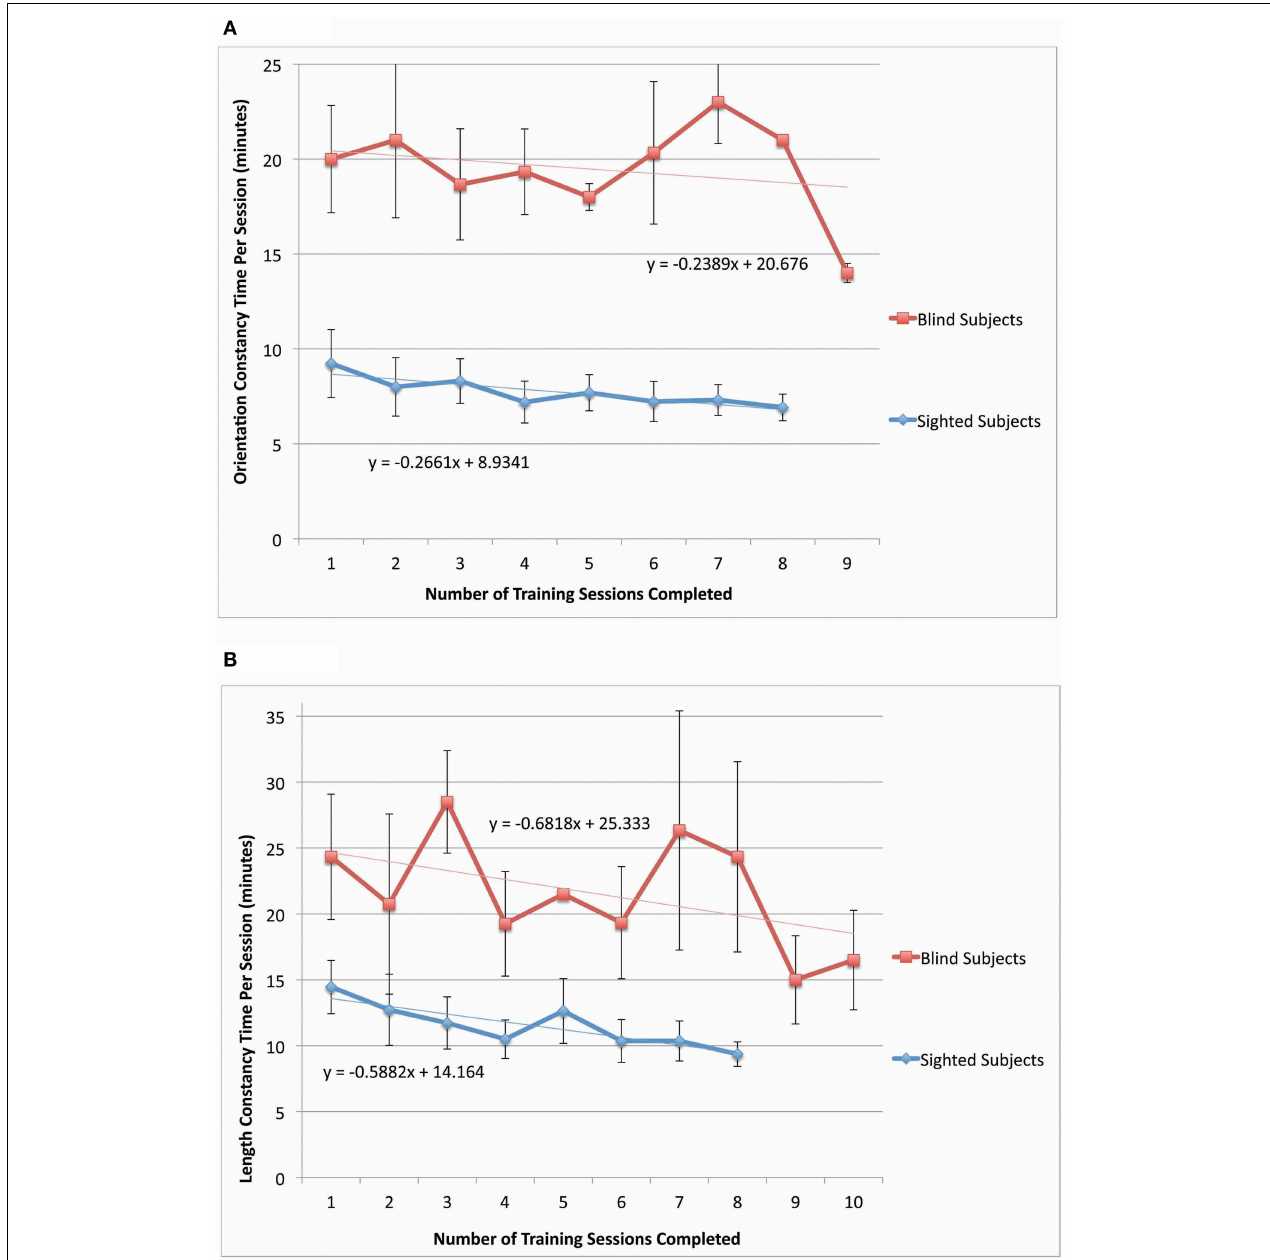
number of training sessions completed. In (A) , one blind participant was omitted from the data due to lack of video from three consecutive sessions. In (B) , one sighted participant was omitted due to an exploratory protocol that included four different transitions between head-tilt allowed trials and no-head-tilt allowed trials. Error bars represent the one standard